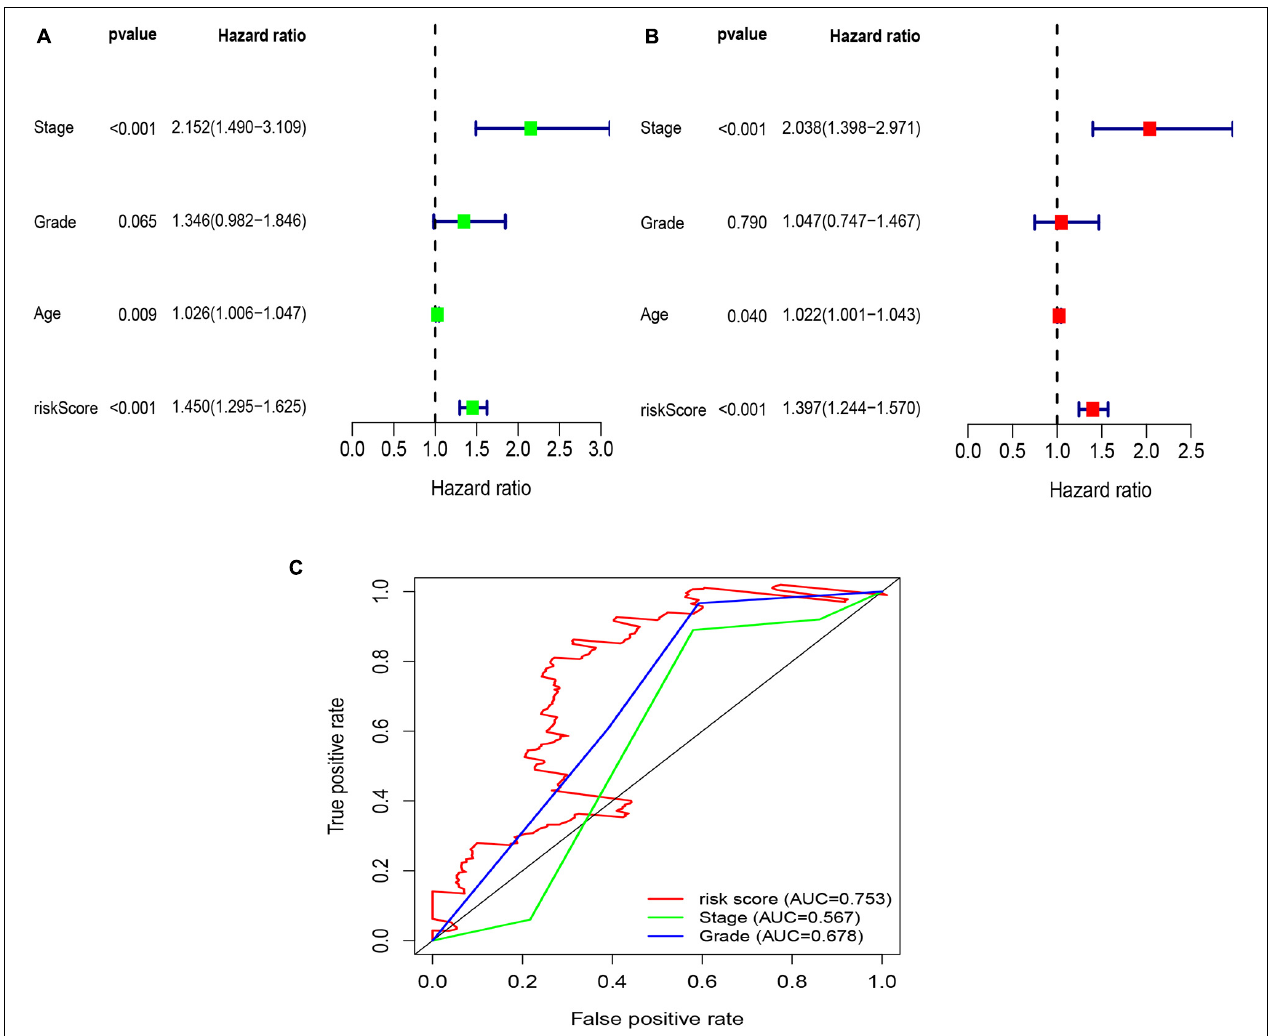
FIGURE 4 | Univariate and multivariate Cox regression analyses based on the risk score and other clinical features in the GSE9891 dataset. (A) Univariate Cox regression analyses. (B) Multivariate Cox regression analyses. (C) ROC curve analysis of the risk score and other clinical